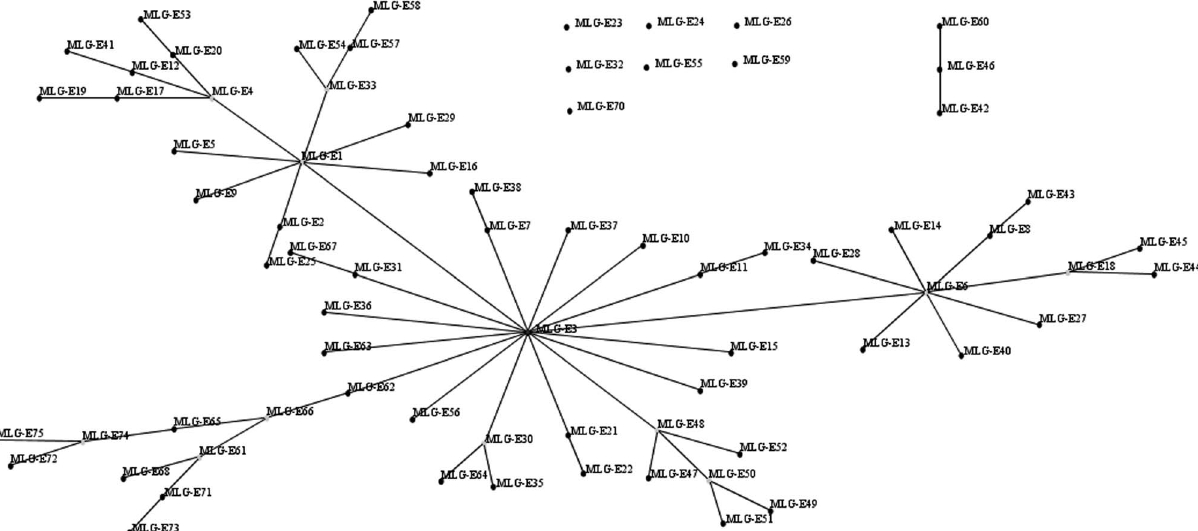
Figure 2. eBURST networks for G. duodenalis assemblage E. Each MLG is represented by a dot. MLG-E3 is the primary founder, and the subgroup founders are MLG-E1, MLG-E4, MLG-E33, MLG-E66, MLG-E61, MLG-E74, MLG-E30, MLG-E48, MLG-E50, MLG-E6, and MLG-E18. The variants are connected by